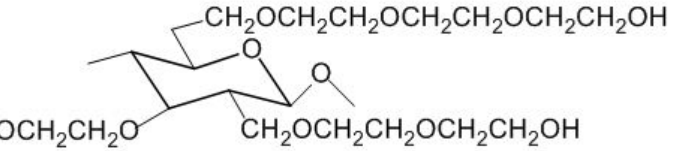
Figure 16. Example of the degree of substitution (DS) (e.g., 3) and molecular substitution (MS) (e.g., 6) on one anhydroglucose unit (AGU) of hydroxyethylcellulose. Most commercial HPC have an MS between 1.5 and 3, corresponding to values of DS between 0.8 and 1.2. An MS of 1 usually denotes water-soluble HPC. On the other hand, HPC is more hydrophobic than HEC. An HEC that is higher than MS is usually soluble in a